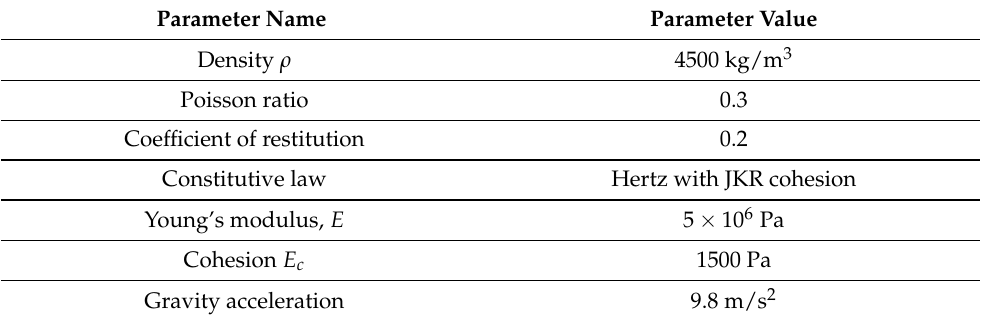
Table 2. Parameters of some packing